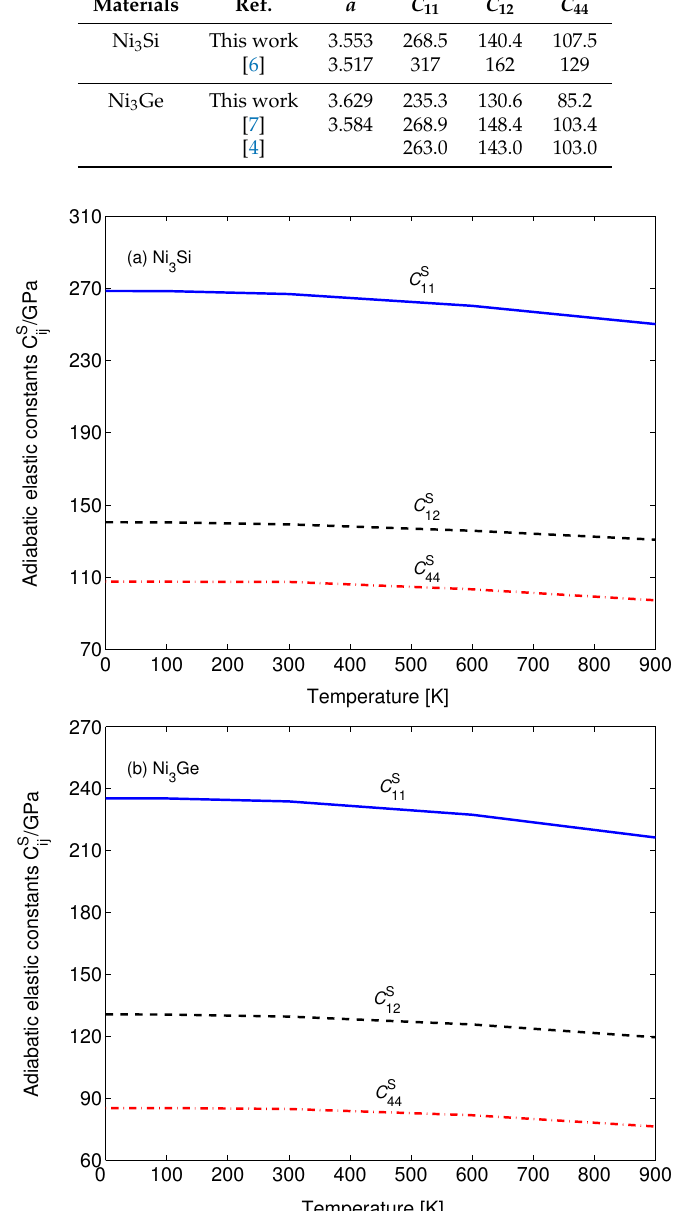
Figure 3. The predicted isentropic elastic constants as a function of temperature for ( a ) Ni 3 Si and ( b ) Ni 3 Ge, respectively. The C S curves,